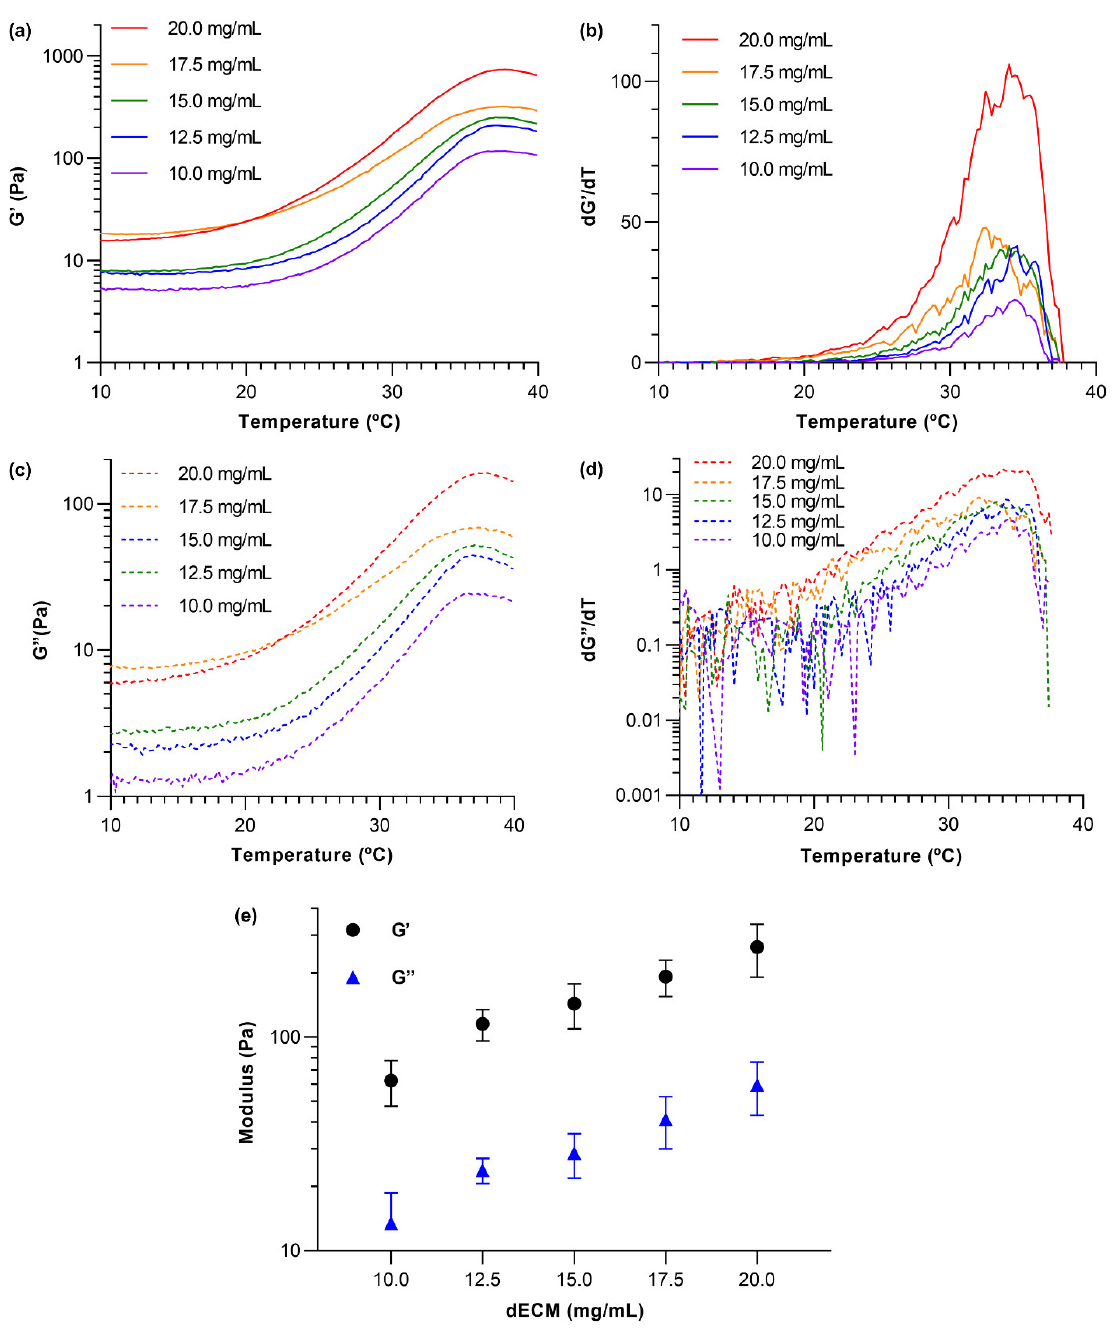
Figure 3. Rheological measurements of dECM hydrogels at different concentrations. ( a ) The storage modulus (G′) was measured as a function of temperature for dECM at various concentrations, ( b ) derivative plot of data presented in (a), ( c ) the loss modulus (G″) was measured as a function of temperature for dECM at various concentrations, ( d ) derivative plot of data presented in (c), ( e ) the average G′ and G″ of dECM hydrogels at different concentrations (statistical analysis and p -values can be found in Figure S3 in the supplementary). N = 3 independently prepared hydrogels and error bars show standard